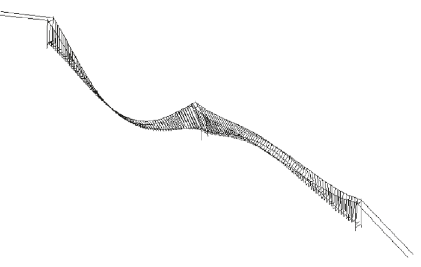
Figure 10: Aerostatic instability form of MYB under an initial attack angle of 0 ∘ .